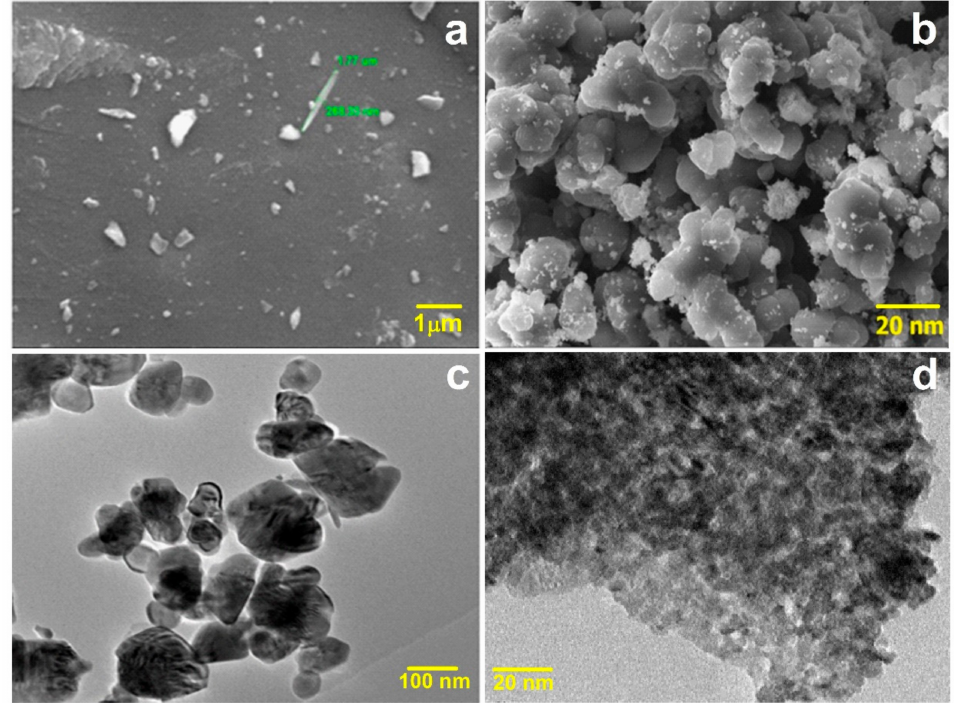
Figure 2. SEM images of ( a ) and ( b ) are CuO and CeO 2 , ( c ) and ( d ) are HR-TEM images of CuO and CeO 2 ,